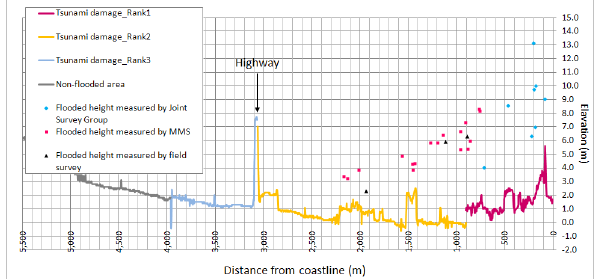
Figure 10. Cross section along EW direction of ground surface and tsunami flood depth on profile A (Yuriage, Natori